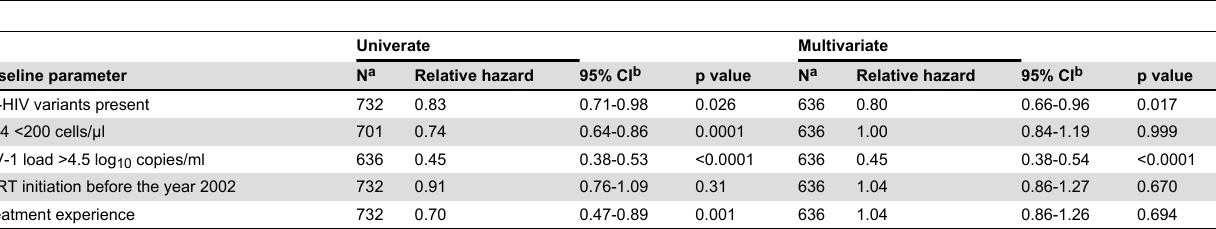
Table 2. Uni- and multivariate analysis of baseline parameters on time to reach undetectable viral loads upon start of cART